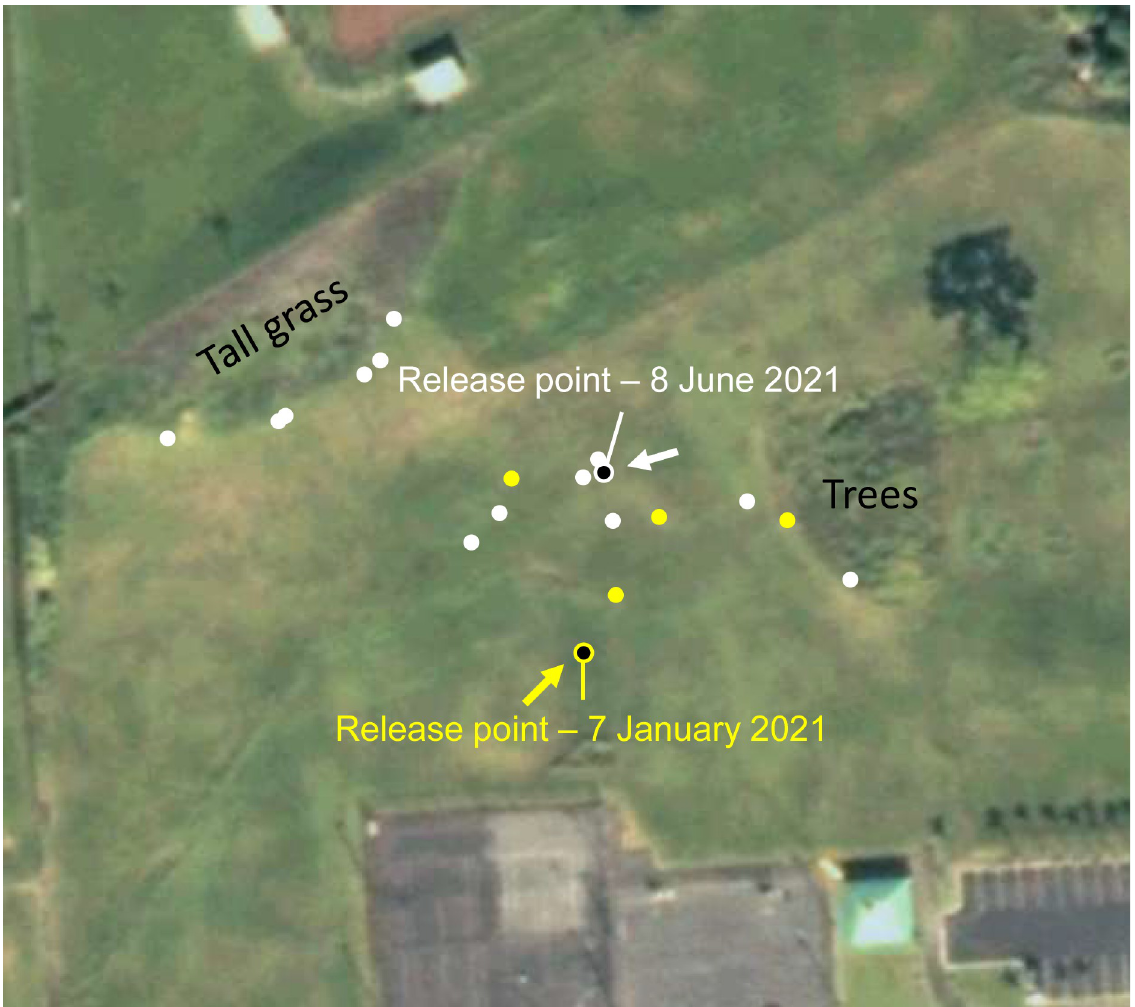
Fig 9. Tagged melon fly, Zeugodacus cucurbitae , release points (black center with yellow or white border) and landing points (yellow or white dots) at Lokahi Park, Hilo, HI. Yellow and white arrows indicate the mean wind direction during fly releases. Source: U.S. Geological Survey, 2011, USGS High Resolution State Orthoimagery for the East Side of Hawaii Island: 05QKB820780_200912_0x5000m_CL_1: U.S. Geological Survey.